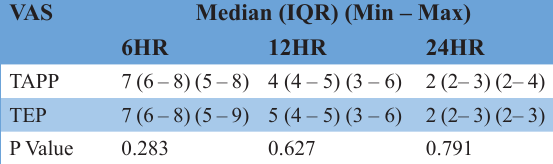
Table 4. Visual analogue scale in TAPP and TEP VAS